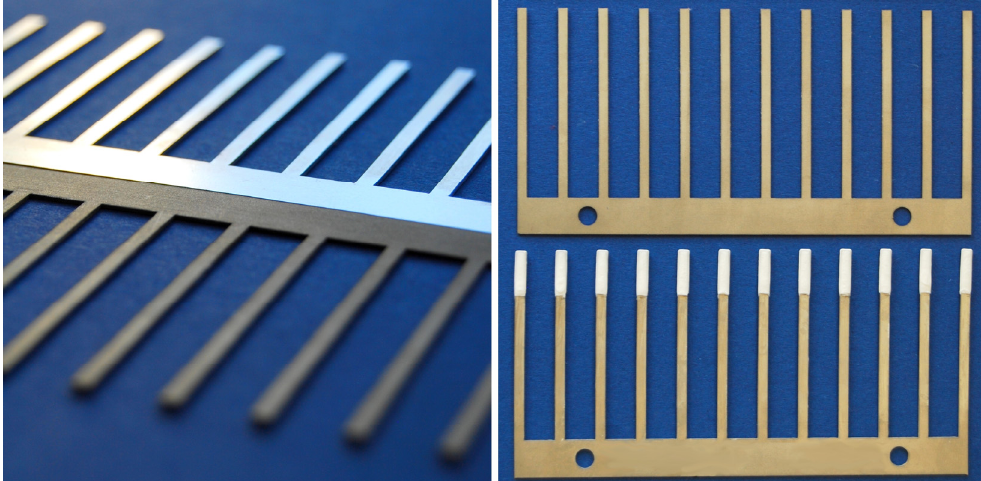
Figure 3. TFME Blades. Left : Metal surface before (top) and after (bottom) etching in hydrochloric acid. Right : TFME blade before (top) and after (bottom) applying coating.